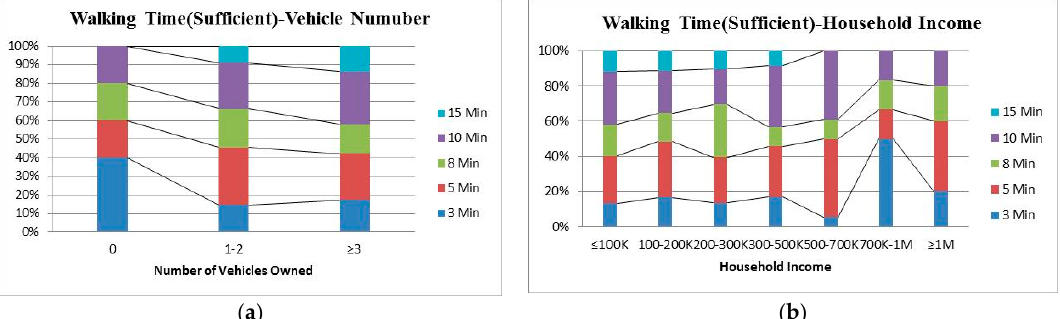
Figure A7. Relationship between walking time and significant variables for BEV with insufficient charge: ( a ) Relationship between walking time and vehicle number; ( b ) Relationship between walking time and household income.